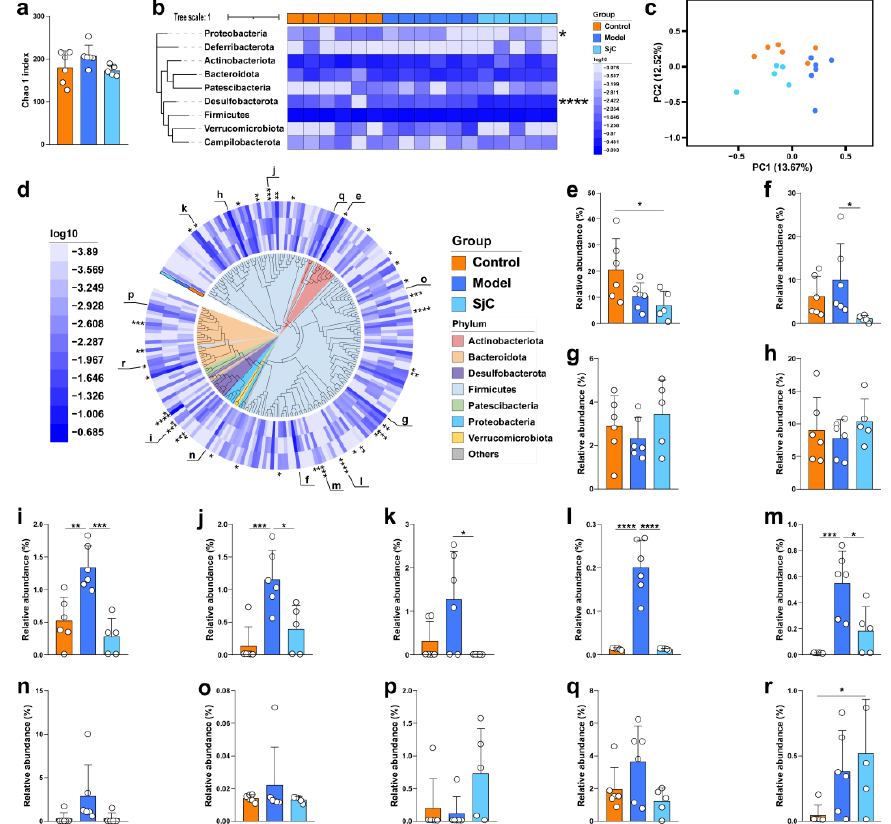
Figure 2. 16S rRNA gene sequencing analysis revealed the effects of SjC administration on gut microbiota composition in HFD-fed mice. ( a ) Chao 1 index. ( b ) Gut microbiota composition at the phylum level. ( c ) Principal component analysis (PCA) of gut microbiota at the species level. ( d ) Gut microbiota composition at the species level. A total of 214 bacterial species were detected and the phylogenetic tree of the 16S rRNA gene sequence of each species showed the average relative abundance of these species in different populations. Relative abundance of ( e ) Coriobacteriaceae UCG-002, ( f ) Lactobacillus , ( g ) Oscillospiraceae , ( h ) Lachnospiraceae , ( i ) Desulfovibrio fairfieldensis , ( j ) Clostridium sp., ( k ) Dorea sp., ( l ) Christensenella minuta , ( m ) Turicibacter , ( n ) Akkermansia , ( o ) UBA1819 , ( p ) Bacteroides acidifaciens , ( q ) Bifidobacterium pseudolongum , and ( r ) Muribaculaceae . All data are expressed by mean ± SEM ( n = 5–6). One-way ANOVA and Tukey multiple comparison analysis were used to analyze